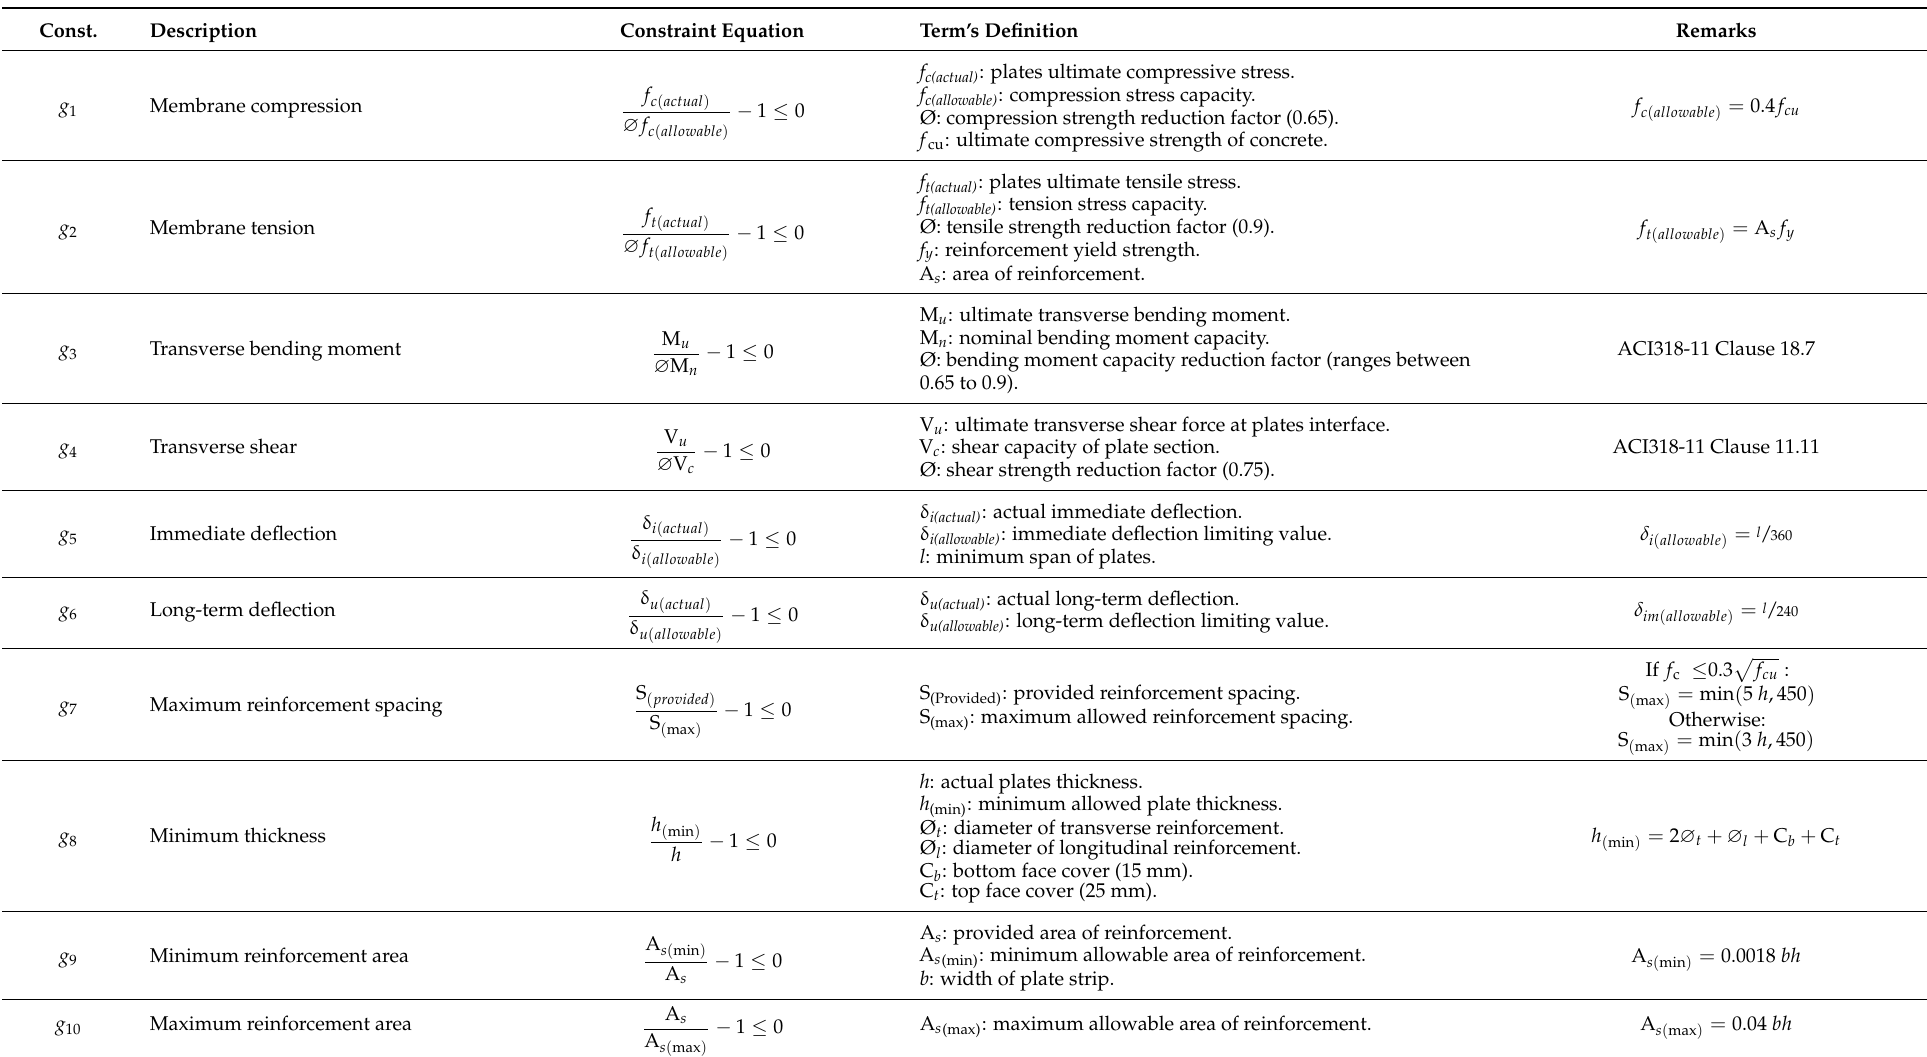
Table 7. Folded plates’ constraints